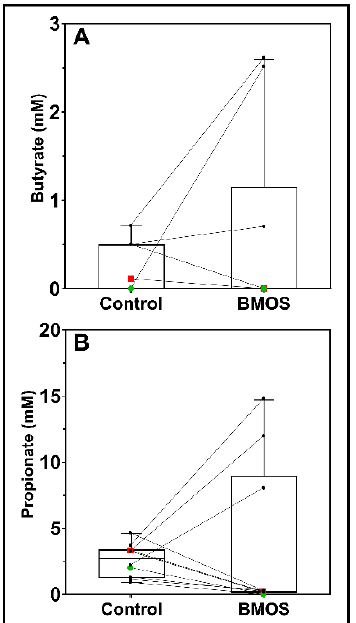
Figure A1. Microbial metabolic activity in terms of butyrate production (mM) ( A ) and propionate production (mM) ( B ) upon a 48 h fermentation of 5 g / L BMOS ( n = 1) by infant fecal microbiota of 10 di ff erent donors, versus their respective blank controls (Control, n = 1). Donors 1 and 8 are colored in red and green, respectively. No significant di ff erences between the average Control and BMOS were obtained, as tested with a paired sample t-test ( p > 0.05).